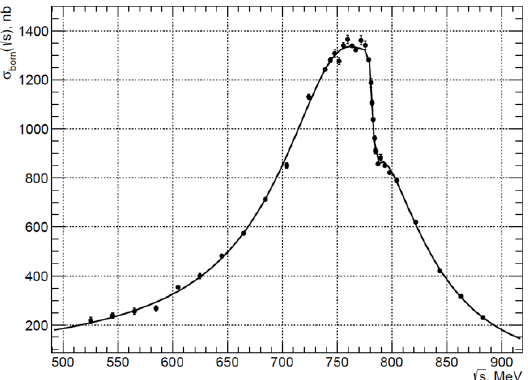
Figure 4: The ratio R = σ ( e + e − → µ + µ − ) /σ